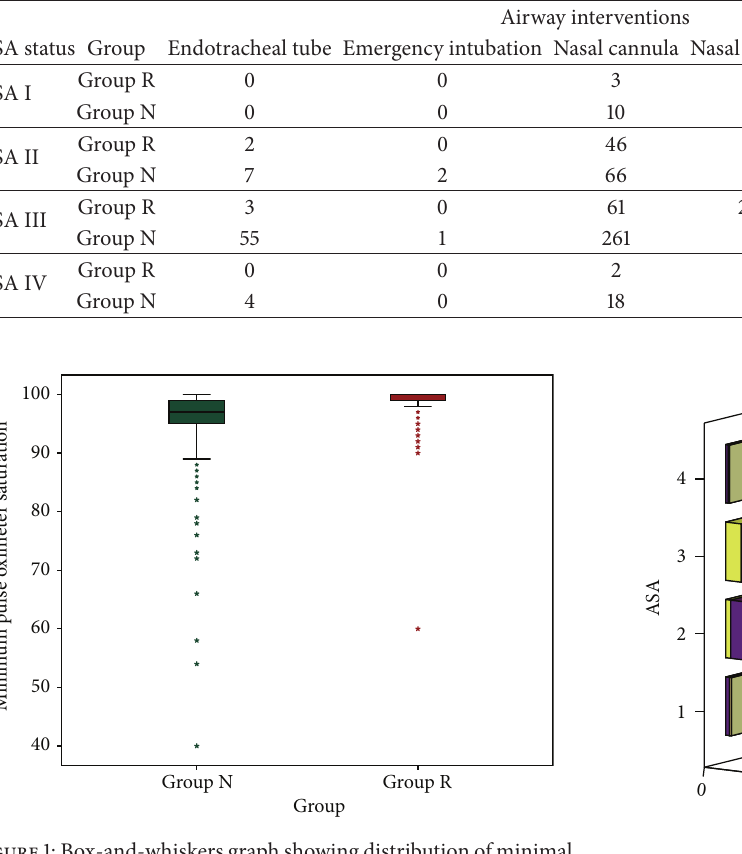
Table 2: “Airway interventions” in both groups.